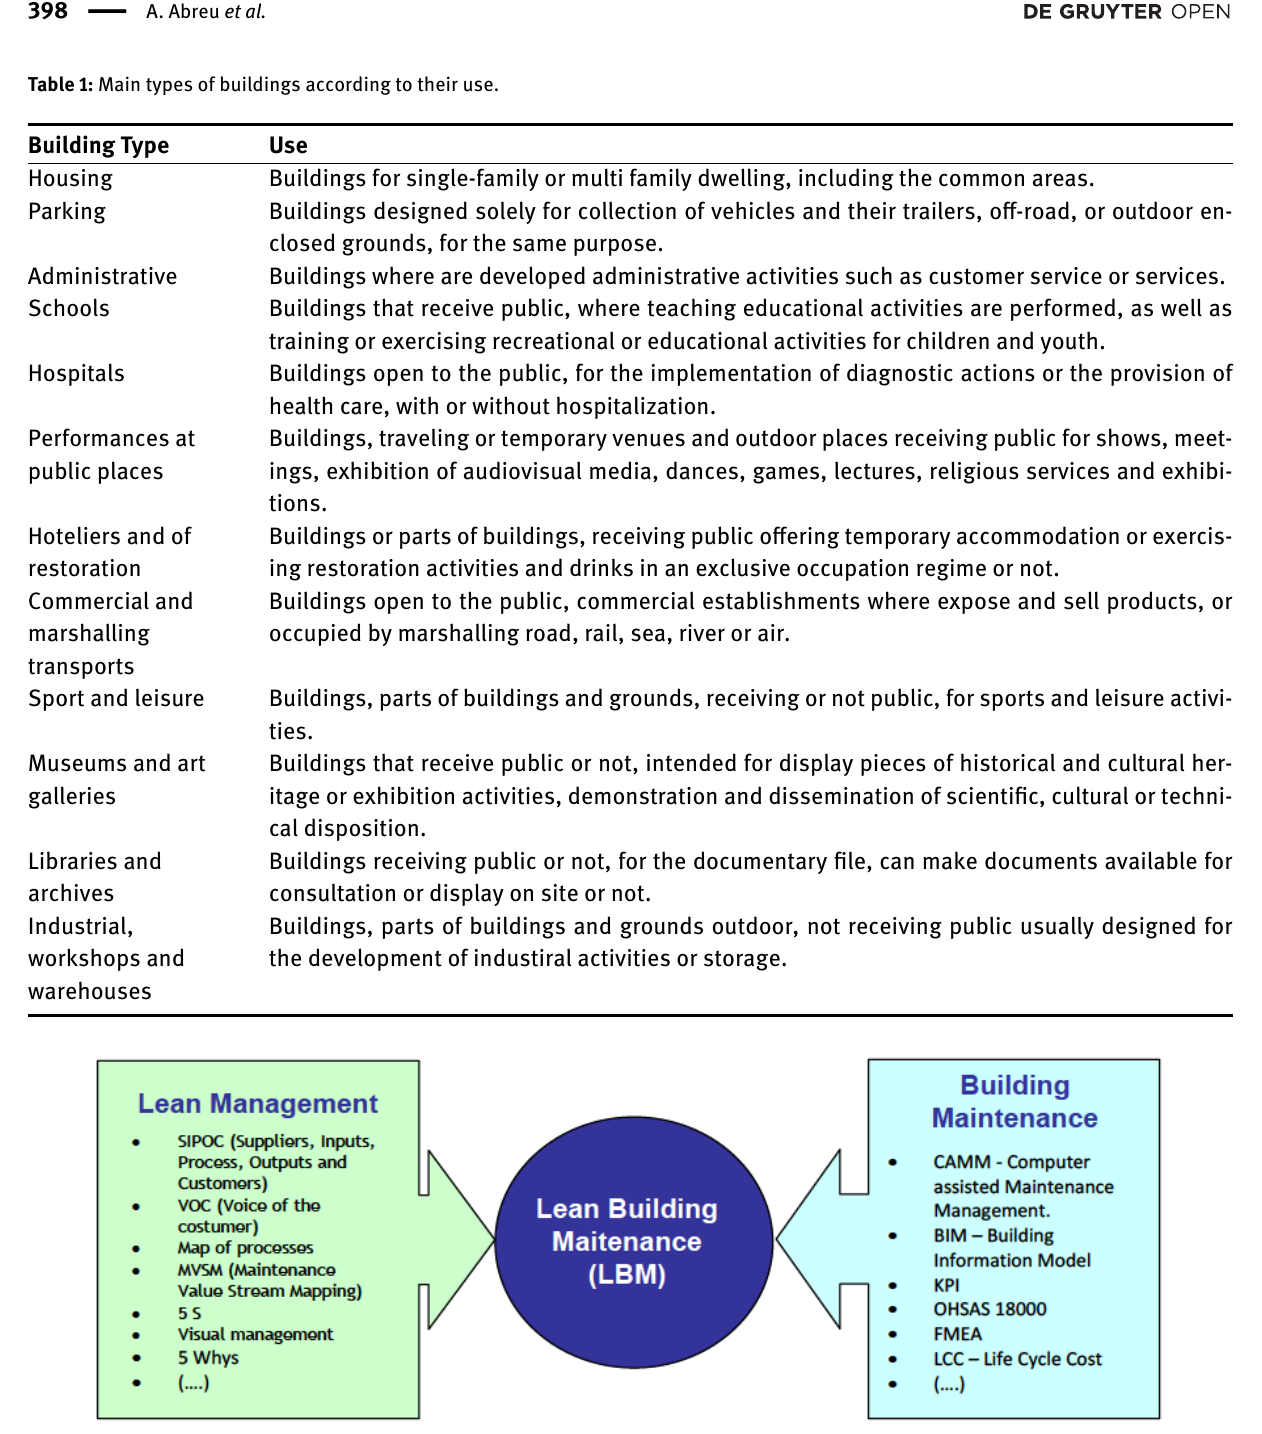
Figure 1: Promising Tools and